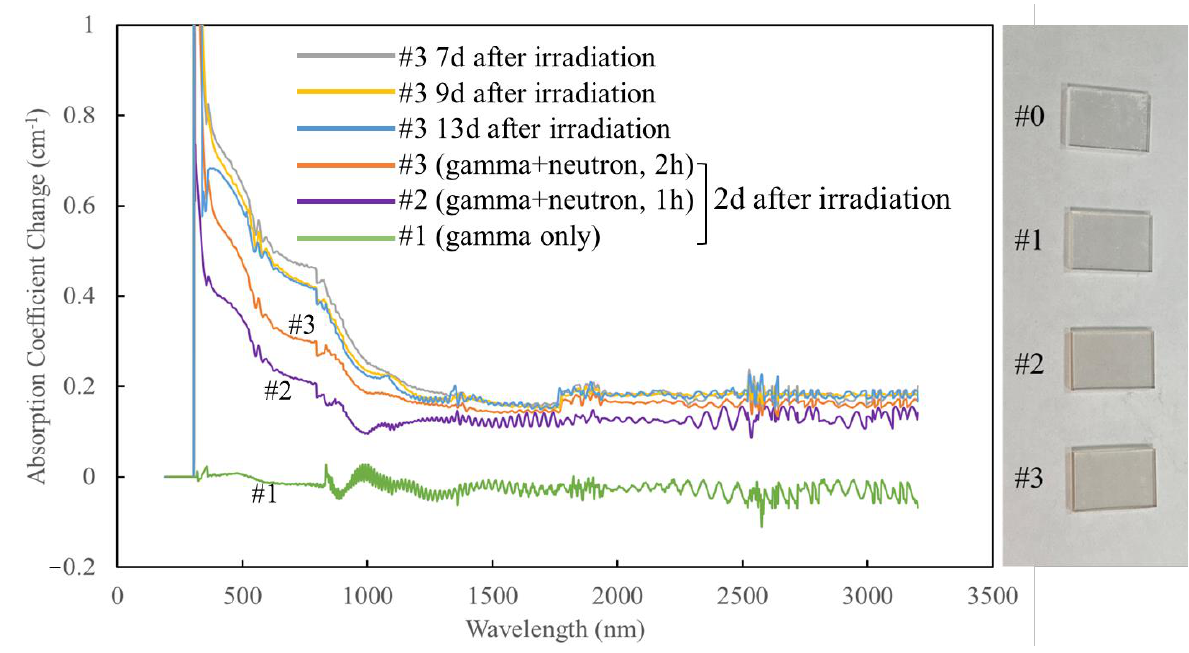
Figure 2. Absorption coefficient change for neutron and gamma-irradiated LiNbO 3 as a function of wavelength. The data curves in the figure are the absorption coefficient changes relative to the reference sample #0. Sample #1 was irradiated with 288-Gy gamma rays and its absorption coefficient changes by almost zero. Samples #2 and #3 were irradiated with neutrons and showed significant changes in absorption. The absorption coefficient change was continuously occurring after the neutron-gamma irradiation. The right photo shows the appearance of the four samples 13 days after irradiation.